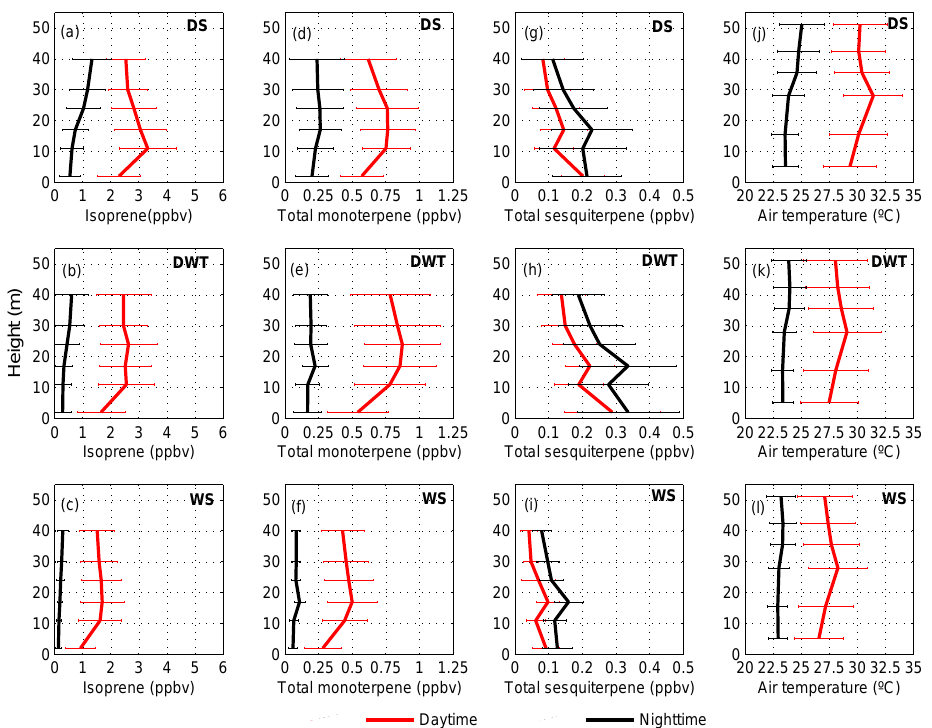
Figure 2. Daytime (10:00–16:00, LT) and nighttime (22:00–04:00, LT) average vertical profiles of isoprene (a, b, c) , total monoterpenes (d, e, f) , total sesquiterpenes (g, h, i) , and air temperature (j, k, l) of the dry season (DS), the dry-to-wet transition season (DWT) and the wet season (WS). Error bars represent 1 standard